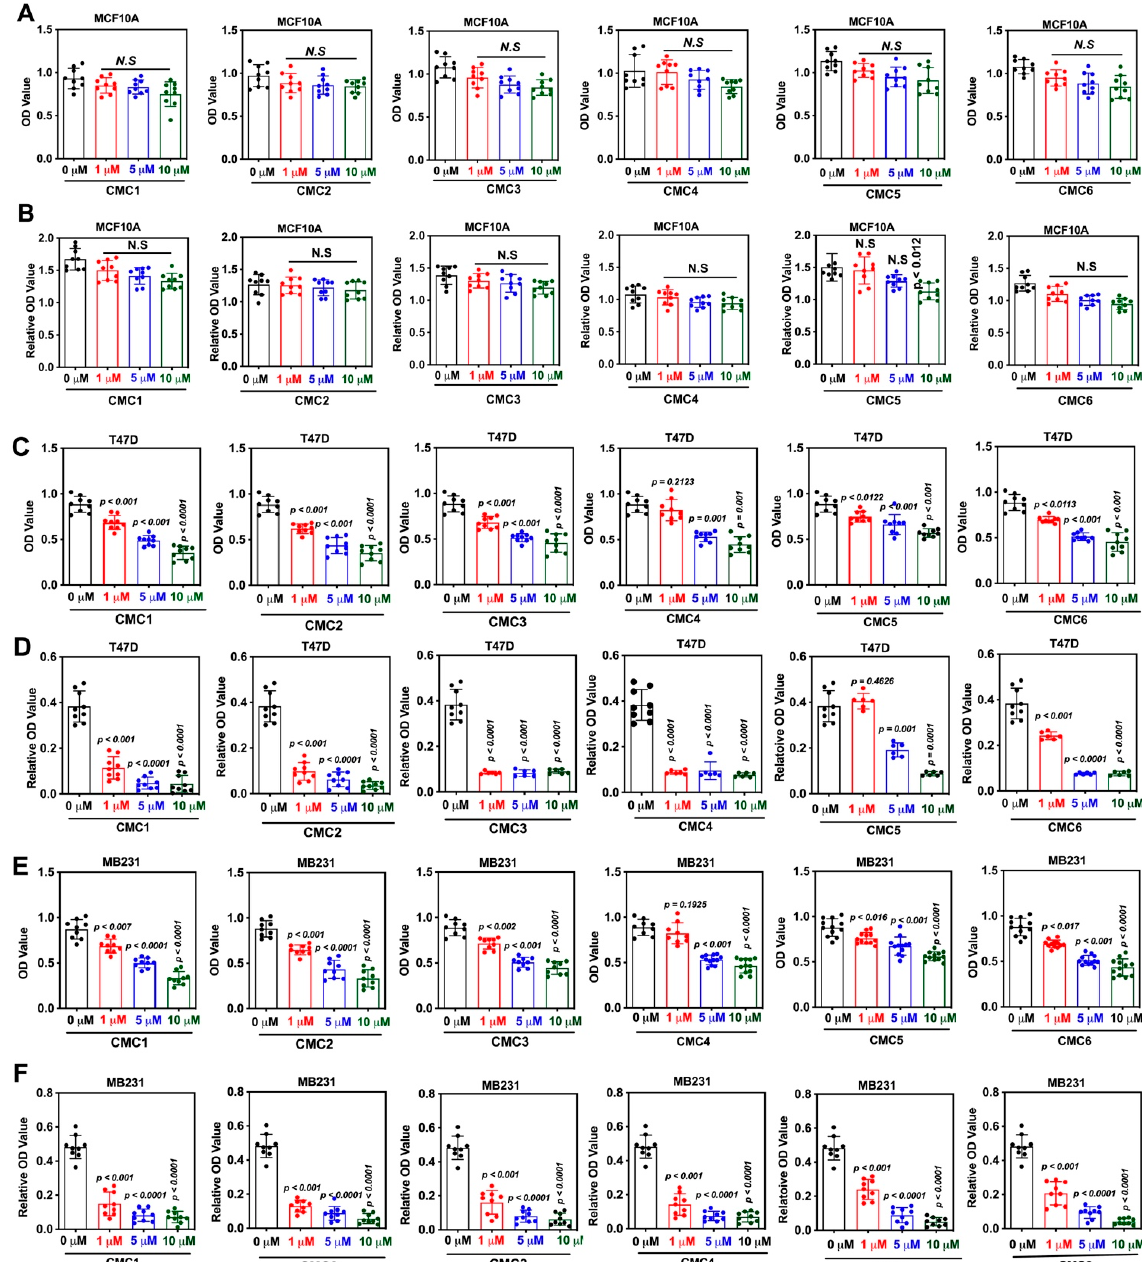
Figure 4. CMC conjugates inhibit human BC cell growth at submicromolar concentration. ( A , C , E ) MTT and ( B , D , F ) colony formation assays were carried out in MCF10A, T47D, and MB231 cells with CMC1–6 at different concentrations (0, 1, 5, and 10 μ M).